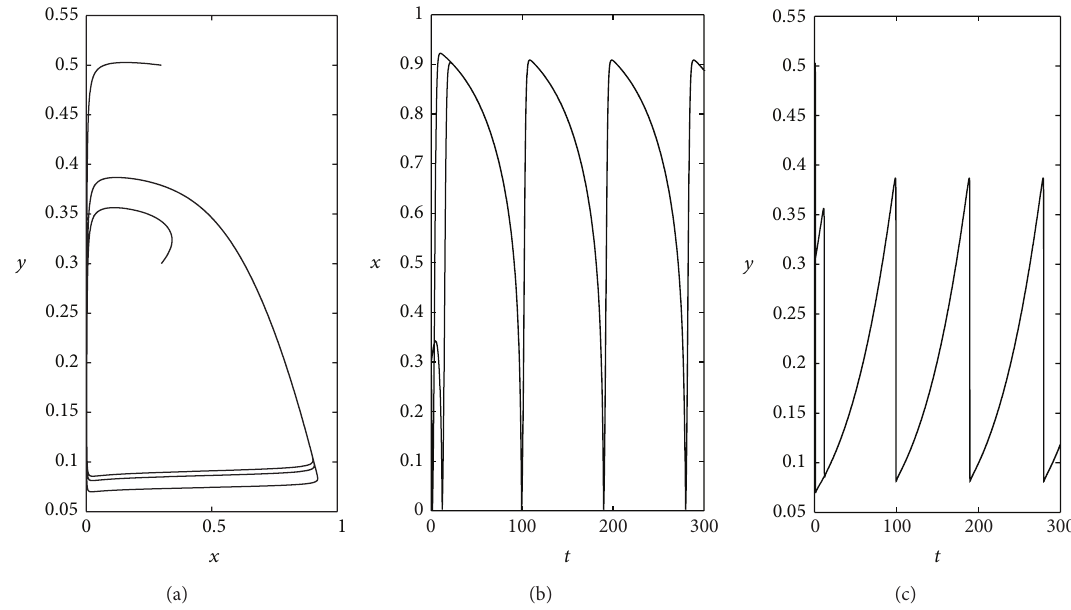
Figure 2: The trajectories of (5) with the fast stage and the slow stage and the corresponding curves of 𝑥 = 𝑥(𝑡) and 𝑦 = 𝑦(𝑡) , where 𝛿 = 3.2 , 𝑎 = 0.15 , 𝜖 = 0.005 , and 𝜆 = 0.001